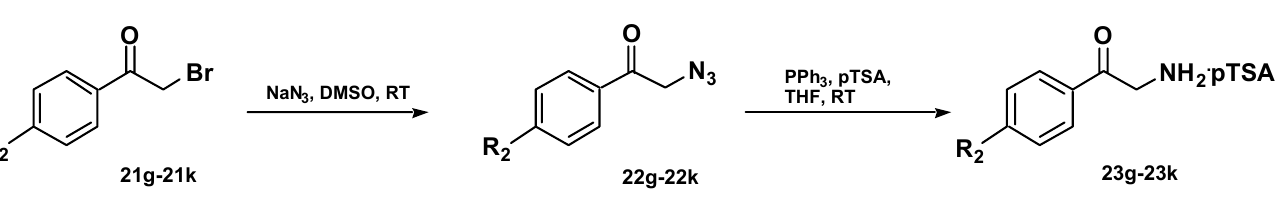
(R = 4'-Cl [g], 4'-H [h], 4'-F [i], 4'-OCH 2